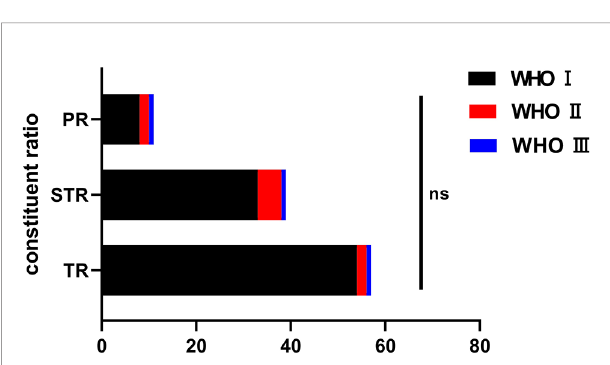
FIGURE 2 | The pathological classi fi cation among the groups and the resection degree. ns, no signi fi cance.